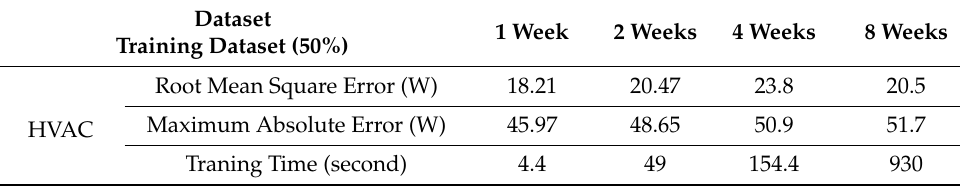
Table 3. Performance indices of the compensation of HVAC data.